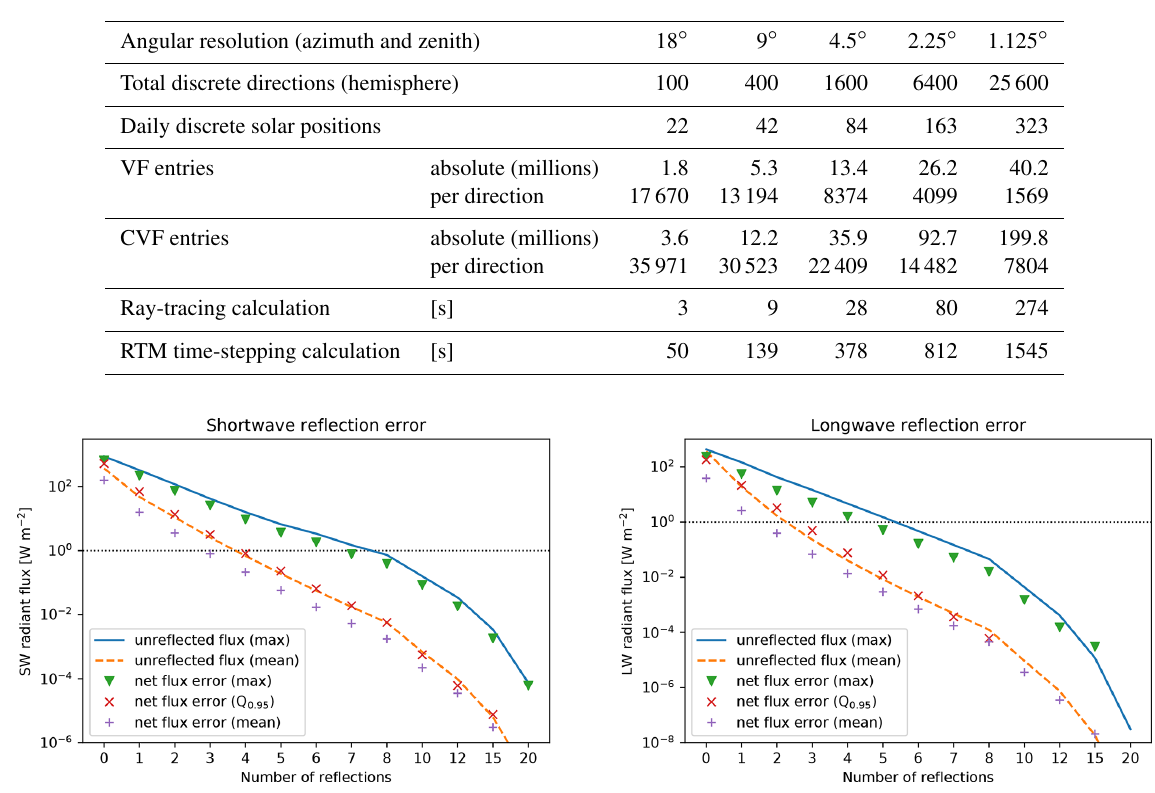
Figure 8. A double-logarithmic presentation of potential and actual errors in SW and LW radiation caused by an insufficient number of reflections. The maximum and mean of the remainder of unreflected radiation per surface are shown as lines; the absolute discrepancies of net radiant flux compared to a perfectly reflected scenario are shown by individual points (maximum, 95th percentile and mean). The net flux errors above 15 reflections are zero (below the floating-point resolution), and so are the 95th percentiles of LW error above 8